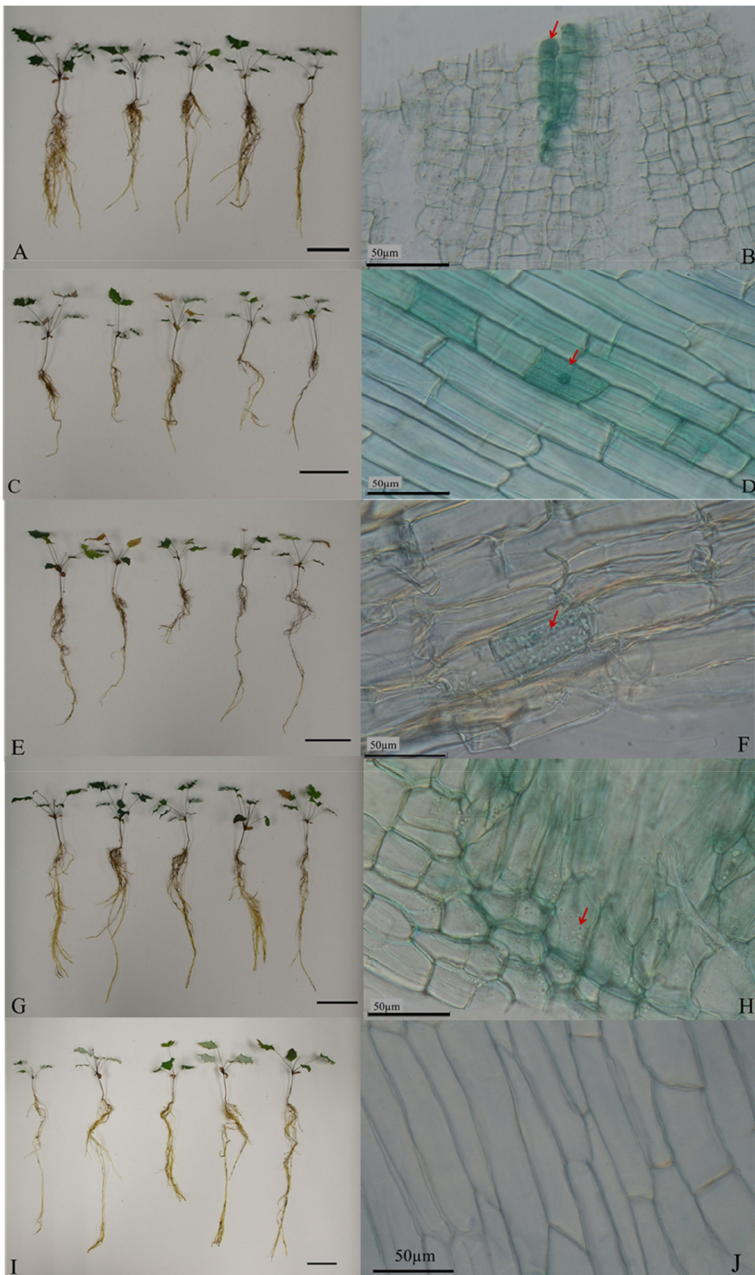
Figure 2. Morphology of M. oiwakensis seedlings after incubation for 3 months: ( A , C , E , G , I ) show M. oiwakensis seedlings of all treatments (bar = 5 cm); ( B , D , F , H , J ) show the root stain for all treatments. ( A , B ): CkDB2-inoculation; ( C , D ): CkDB5-inoculation; ( E , F ): MoAL2-inoculation; ( G , H ): MoAL5- inoculation; ( I , J ): Control. Hyaline microsclerotia-like formations